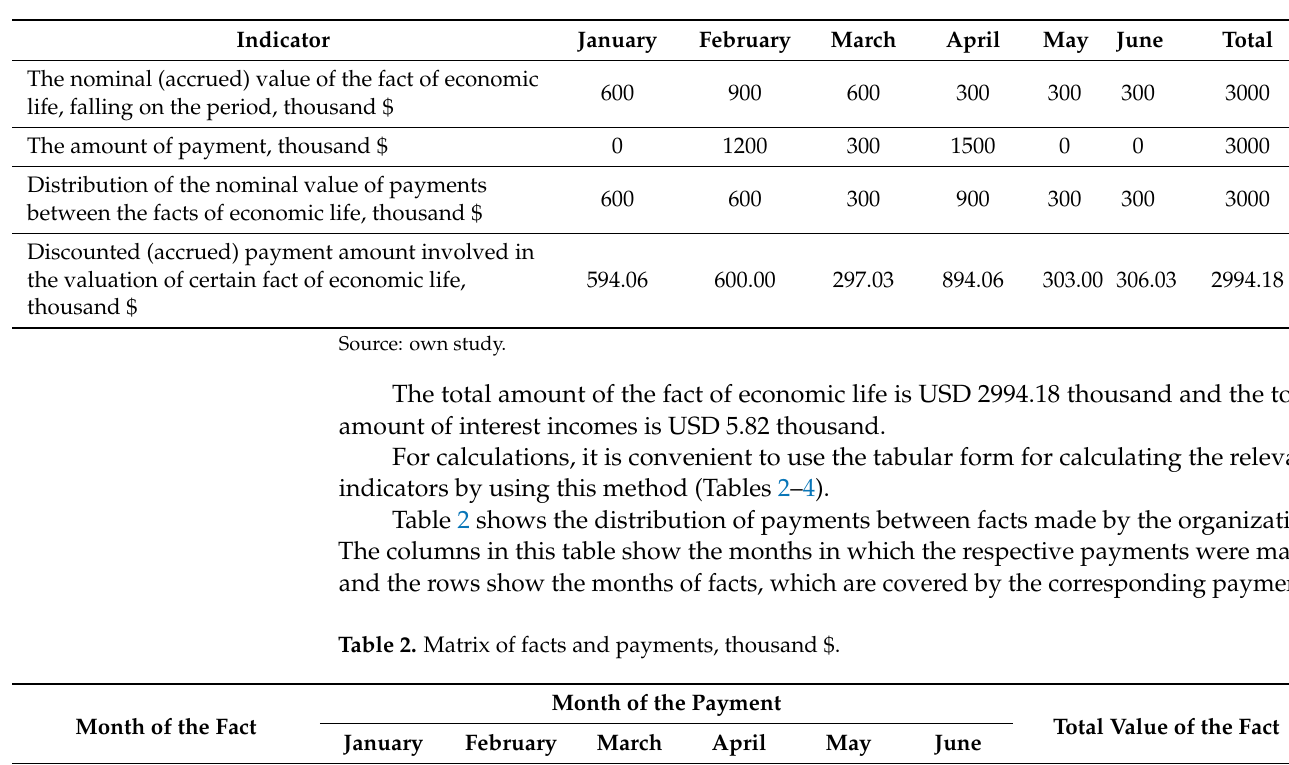
Table 1. Distribution of payments between the facts of economic life in accordance with the FPFS method.